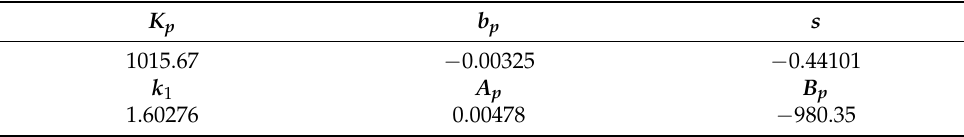
Table 6. The determined material constants for the modified FB phenomenological